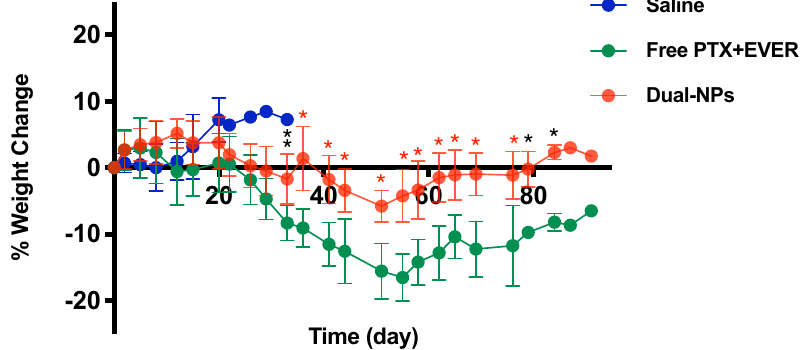
Figure 4. Animal body weight change in mice receiving saline (blue), free paclitaxel and everolimus (PTX + EVER) (green), and dual-targeted PTX + EVER-loaded nanoparticles (Dual-NPs) (red) from the first day of treatment to the ethical endpoint. Data represent mean ± SD ( n = 8). Two-way analysis of variance (ANOVA) was conducted where *, **, and * indicate p < 0.04, p = 0.004, and p < 0.0001, respectively.